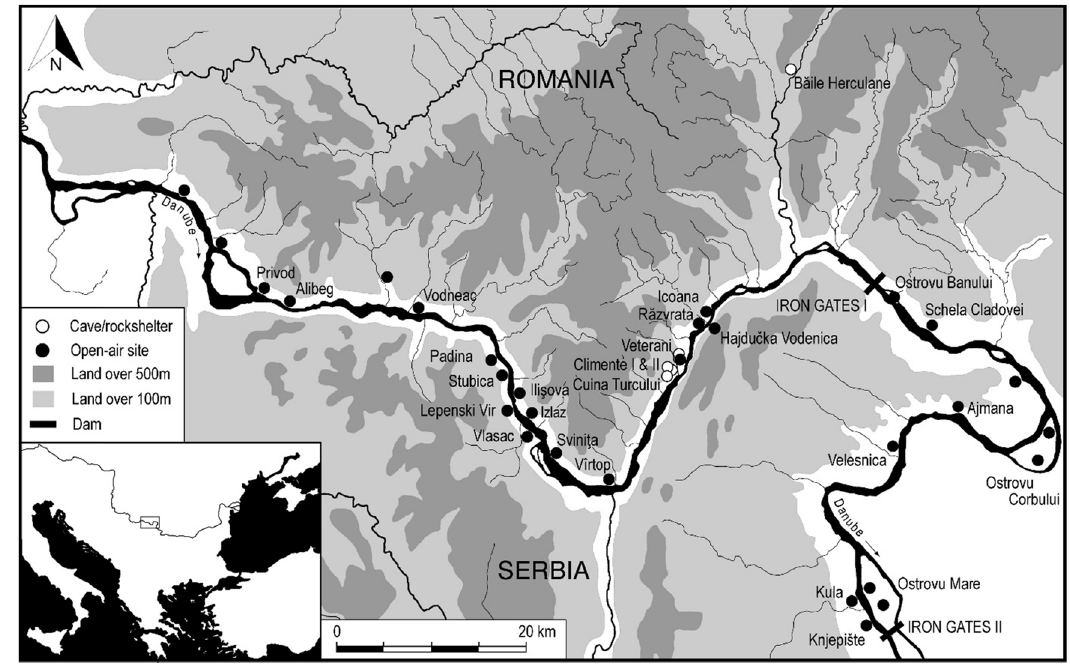
Figure 1: Map of Iron Gates region ( after Bonsall, 2008. Courtesy of the authors )